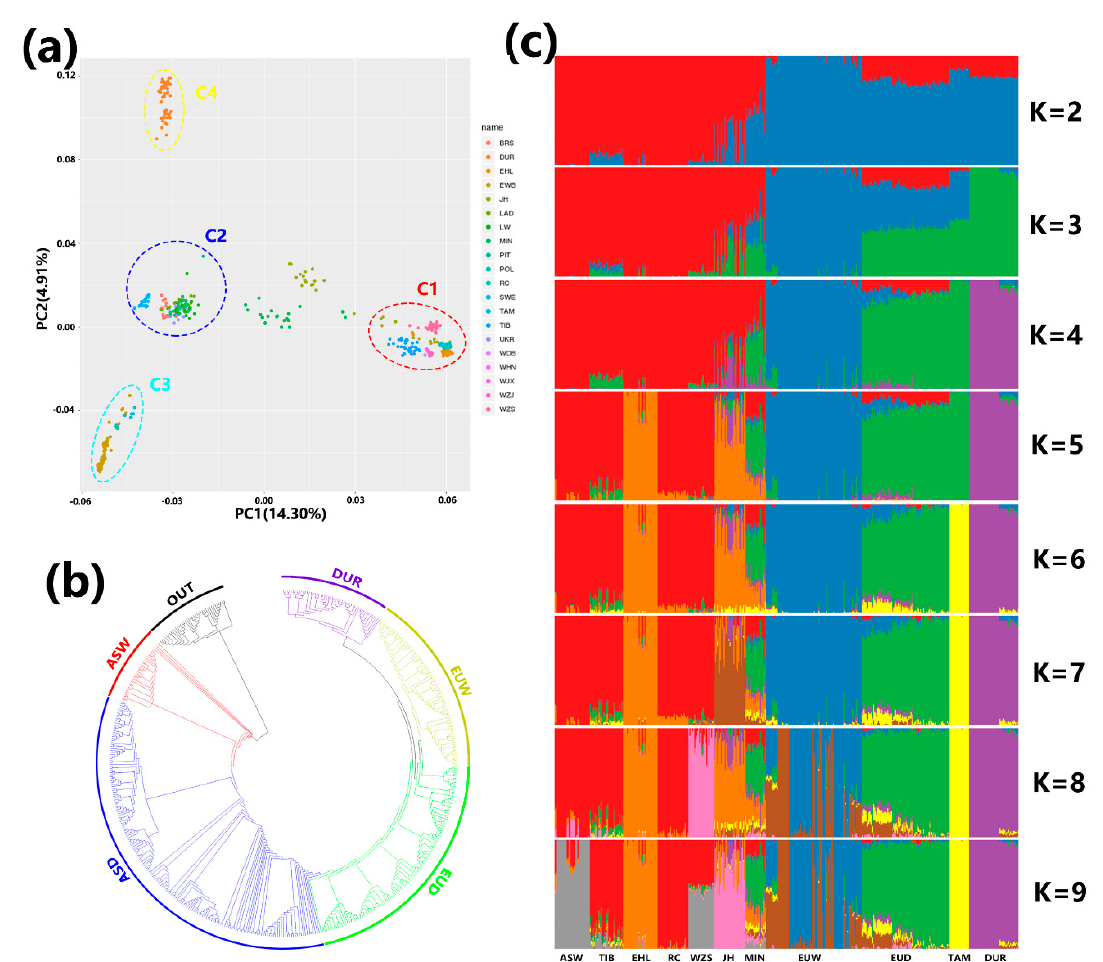
Figure 2. ( a ) Principal component analysis of 486 individuals from the 19 breeds under study. C1: Chinese breeds; C2: European domesticated pigs; C3: European wild boars; C4: Duroc. ( b ) Neighbor-joining tree showing relationships among the 20 populations. ( c ) Bar plot showing ancestry composition generated using ADMIXTURE with the assumed number of ancestries (K) varying from 2 to 9. ASW (Asian wild boar) includes DBW (Dongbei boara), HNW (South China boar), JXW (Jiangxi boar), and ZJW (Zhejiang boar). EUW (European wild boar) includes POL (Polish boar) and EUW (other European boar). EUD (European domesticated pig) includes BRS (British Saddleback), LAD (Landrace), LW (Large White), and PIT